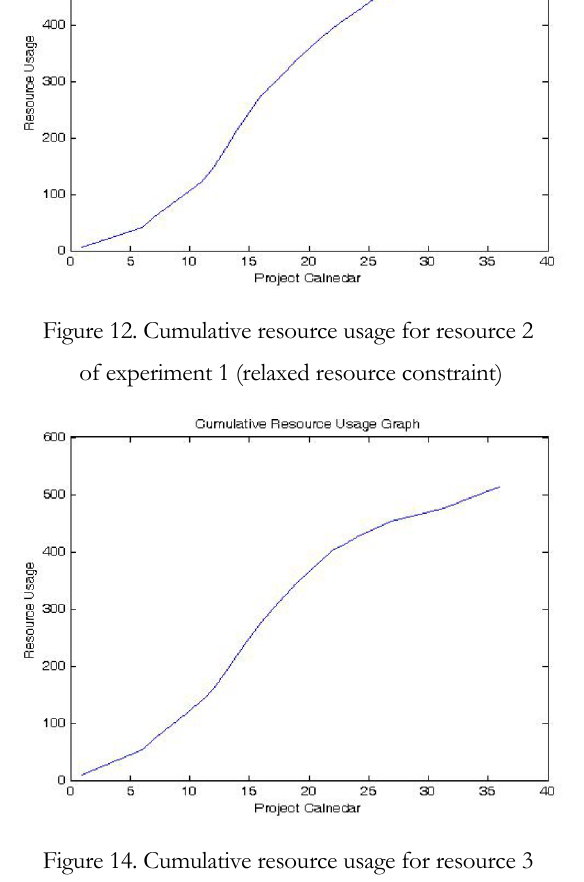
Figure 14. Cumulative resource usage for resource 3 of experiment 1 (relaxed resource constraint)